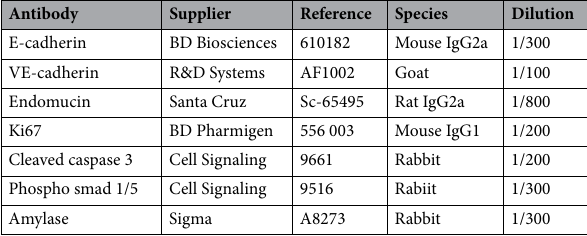
Table 2. Antibodies.